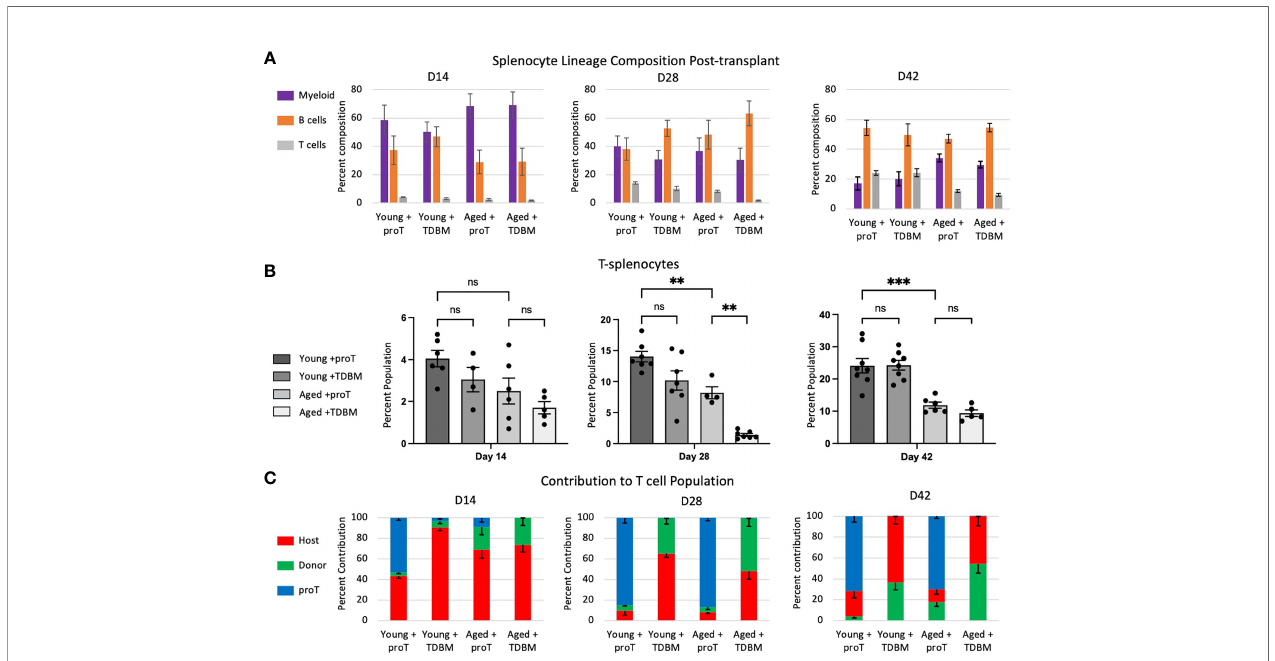
FIGURE 5 | Cellular composition of the spleen post proT adoptive transfer. Mice were treated as indicated in Figure 4 . Spleens dissected from these mice were processed into single cells and their lineage composition of myeloid (CD11b + ), B cell (CD19 + ) and T cells (gated fi rst on CD11b - and CD19 - population and then on CD3 + or CD4 + and CD8 + ) was determined through fl ow cytometry (A) . In (B) , only the T cell percentage is shown for direct comparison. (C) We determined which origin T splenocytes are derived by fl ow cytometry and expression of CD45.2 + GFP - (Host, red), CD45.2 + GFP + (Donor, green) and CD45.1 + (proT, blue). Error bars indicated SEM. Statistical signi fi cance was determined using one-way ANOVA, ** p < 0.01, *** p <